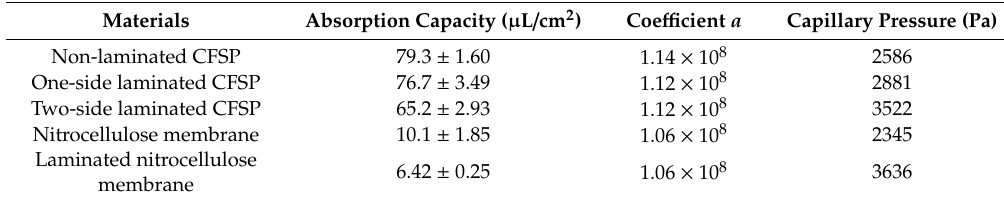
Figure 10. The fluidic resistance over time: ( a ) Non-laminated NC with various widths of paper strips ( b ) Laminated NC ( c ) Various laminated conditions under the same width of paper strips. Table 8. The capillary pressure estimated by our model.